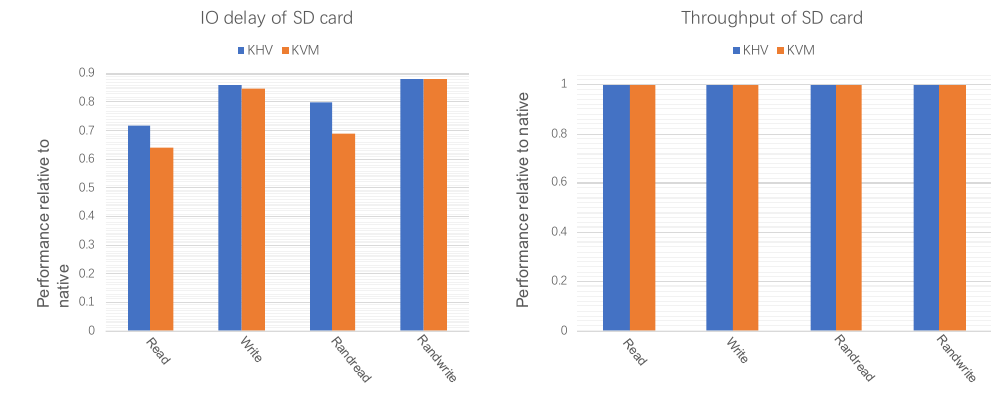
Figure 16. IO delay and throughput of SD